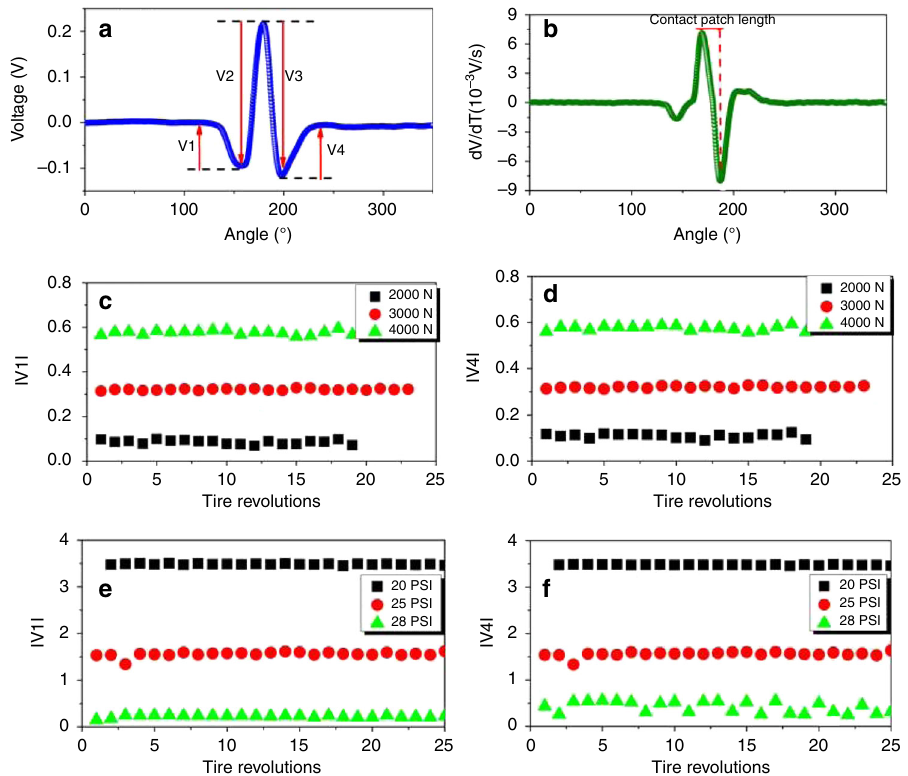
Fig. 5 Experimental results of the printed tire sensor. a The voltage output signal in a full tire revolution for the tire with pressure of 28 psi, velocity of 5 mph, and the normal load of 2000 N. b The time derivative of voltage signal. The effects of tire normal load on (tire pressure = 28 psi, velocity = 5 mph). c The magnitude of parameter V1. d The magnitude of parameter V4. The effects of tire in fl ation pressure on (tire load = 2000N, velocity = 20 mph). e The magnitude of parameter V1. f The magnitude of parameter V4.